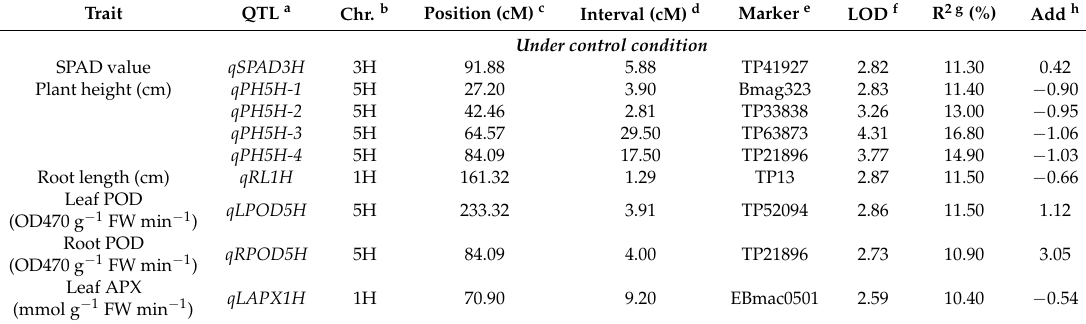
Figure 2. Quantitative trait loci (QTL) significantly associated with different parameters linked to cadmium (Cd) tolerance in the Suyinmai 2 × Weisuobuzhi doubled haploid (DH) population obtained using the multiple QTL model (MQM) mapping method. QTLs in black and red were detected in control and 10 µM Cd conditions, respectively. The one- and two-logarithm of odds (LOD) support intervals for each of the QTLs, as calculated in Mapchart, are displayed on the right side of each linkage group. Table 2. Quantitative trait loci (QTLs) identified under control and 10 µM Cd condition.